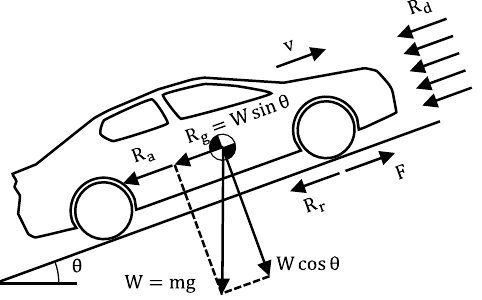
Figure 4. Driving resistance forces affecting on a moving vehicle.